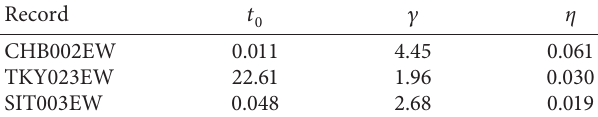
Table 3: Parameters controlling envelope of motions.